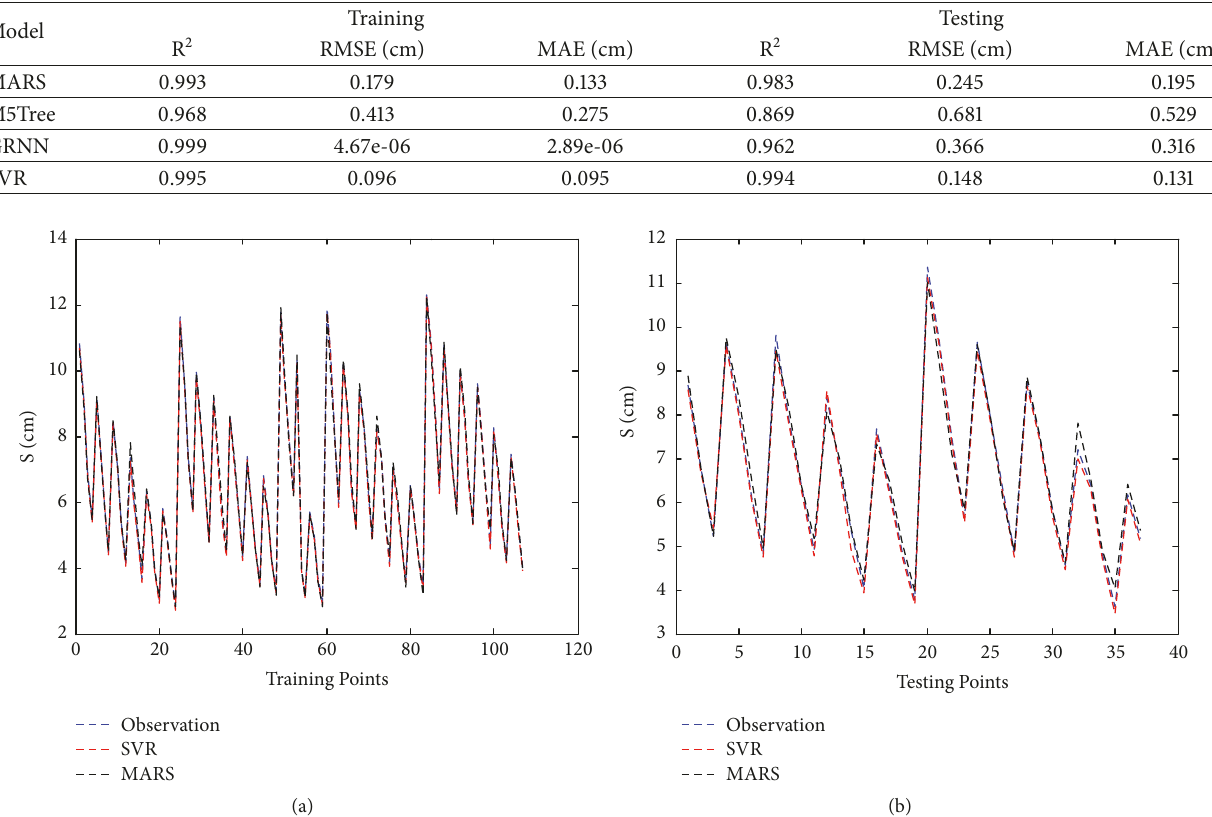
Figure 10: Measured and predicted values for the SVR and MARS models for the (a) training and (b) testing